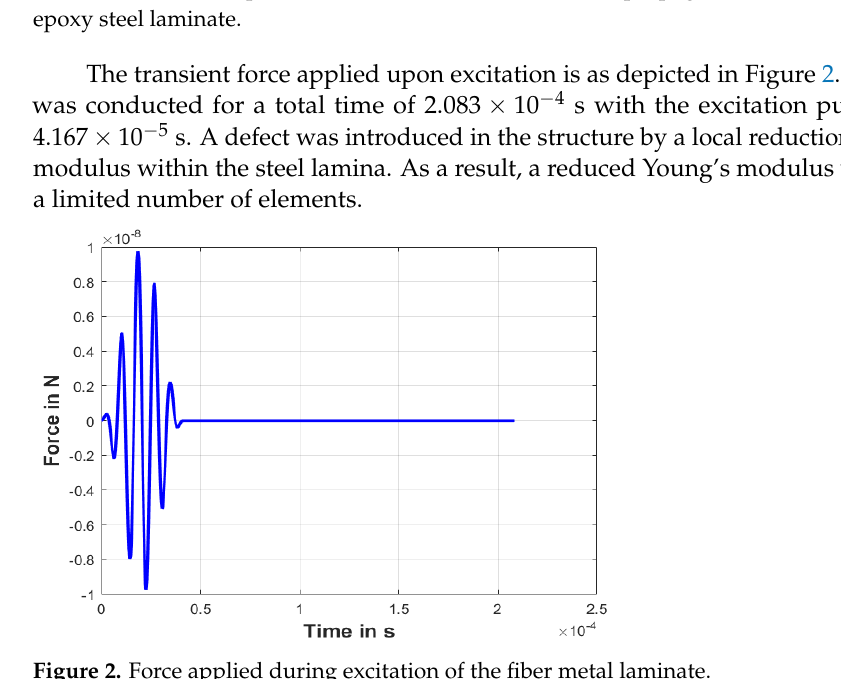
Figure 2. Force applied during excitation of the fiber metal